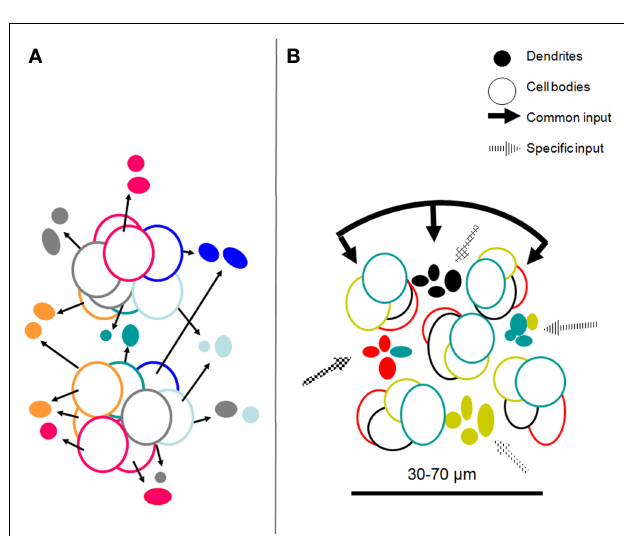
FIGURE 5 | (A) Topographical relations between minicolumns and dendritic bundles summarizing information from Massing and Fleischhauer (1973), Peters and Kara (1987; inspired by their Figure 3) and Vercelli et al. (2004). Dendrites are shown as “clusters” as they appear in transverse sections; the cell body outlines belong to neurons in minicolumns adjacent to the bundles; they are in different layers but are projected on the plane of the dendrites. The colors refer to specifi c targets or combinations of targets for each dendritic bundle and their parent somata (see Figure 4) . (B) Model of a COU in layer III of V1 with bundles of apical dendrites of neurons projecting to four different targets (colors).The COU is defi ned as an assembly of apical dendritic bundles, large enough to include each of the outputs to distant cortical or subcortical structures, of a given cortical locale (area or part of an area), their parent somata and basal dendrites, and the portion of the neuropil which pertains to them. It receives a common input to the apical and basal (not shown) dendrites as well as specifi c inputs to the different dendritic bundles. The distance between the dendritic bundles and between minicolumns 30–70 µm is similar and corresponds to the minimal transverse diameter of an orientation column in the visual cortex, estimated electrophysiologically.